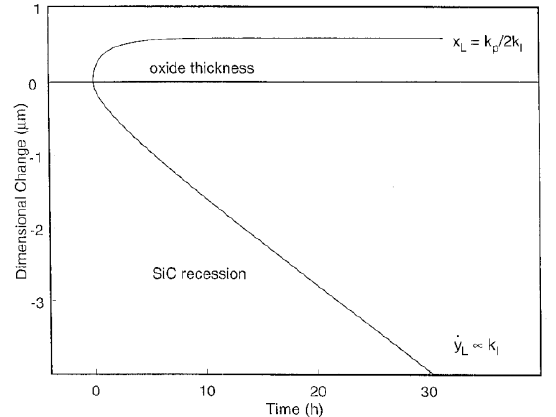
Figure 15. Dimensional change for SiC due to paralinear oxidation and volatilization. Oxide thickness and SiC recession curves calculated for k p = 0.25 mil 2 /h and k 1 = 0.21 mil/h (1 mil = 1 × 10 − 3 in. = 25.4 µ m). Reprinted with permission from Reference [64]. Copyright 2003 The American Ceramic Society/Wiley.